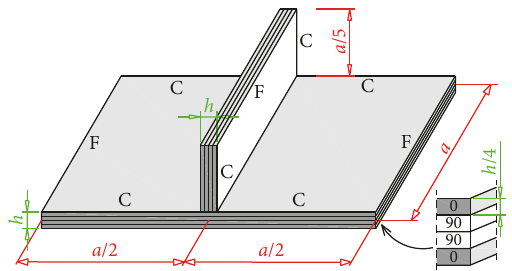
Figure 8: Geometry and boundary conditions of laminated composite plate with a single stiffener.